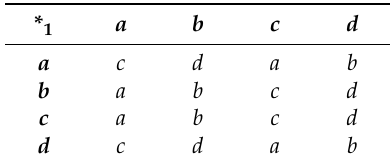
Table 3. The operation * 1 on N 1 .